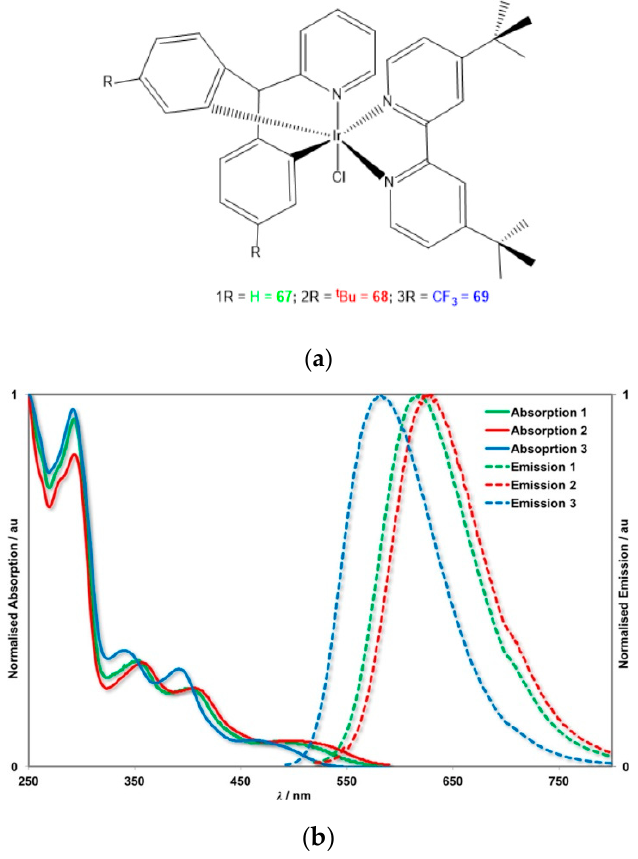
Figure 7. ( a ) Structures of chelating tridentate tripod Ir(III) complexes ( b ) Normalized UV-Vis absorption and photoluminescence spectral of 67–69 in CH 2 Cl 2 at 298 K [82] [Adapted with permission from (Hierlinger et al.). Copyright (2017) American Chemical